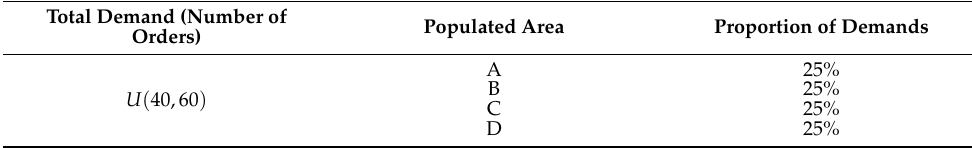
Table 4. Demand distribution.